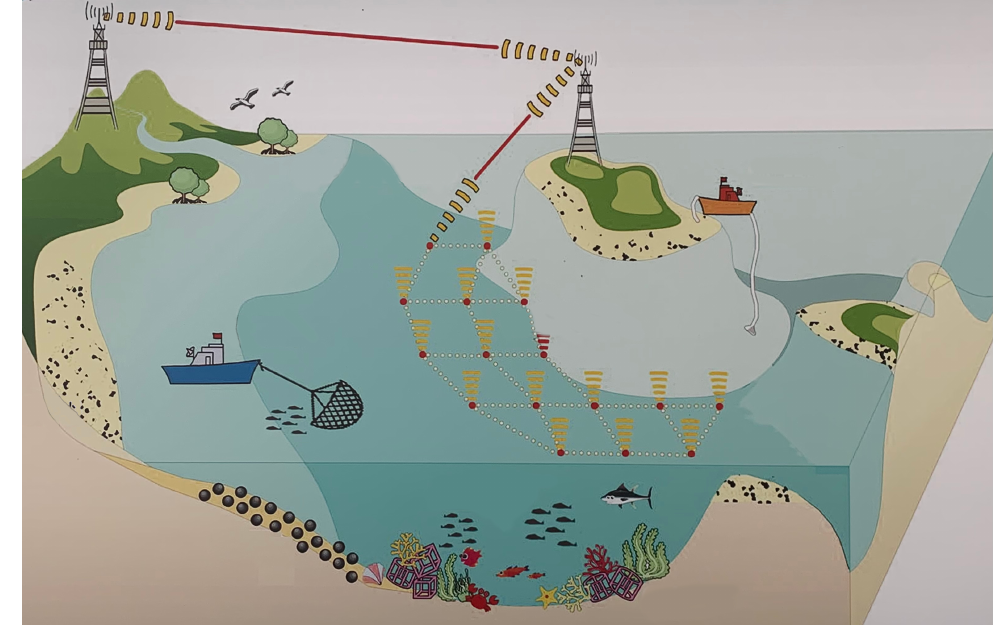
Figure 1. Schematic of vessel monitoring system